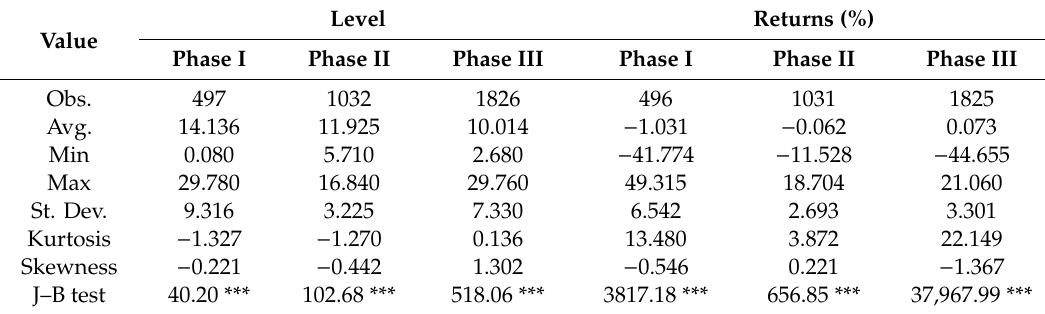
Table 3. Descriptive